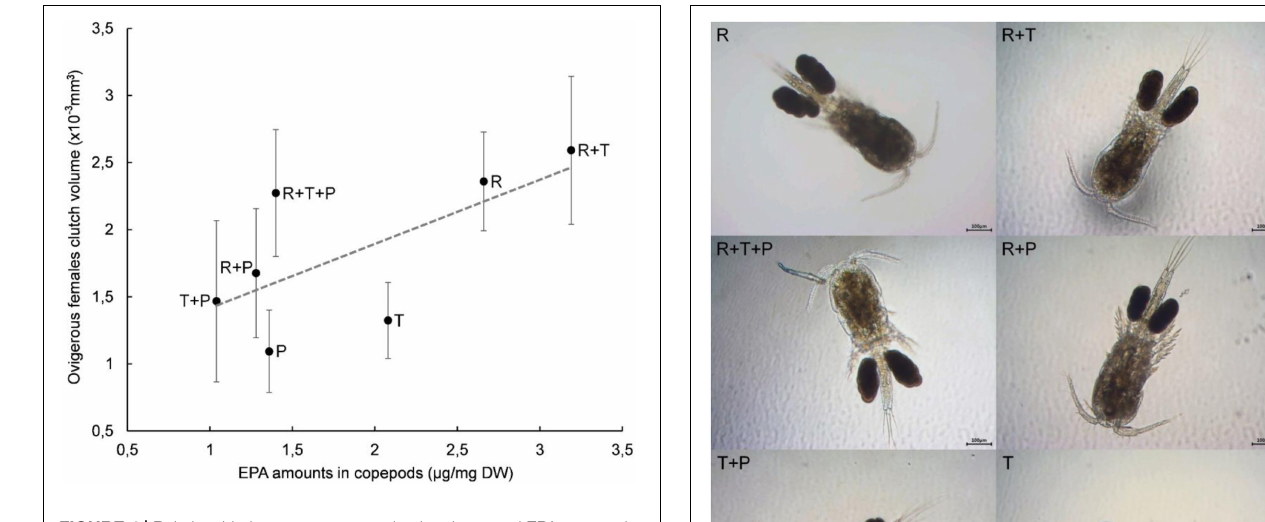
FIGURE 4 | Relationship between average clutch volume and EPA amount in Paracyclopina nana ovigerous females for each microalgal diet. Error bars show the standard deviations obtained from n = 20 females. Dashed line corresponds to the linear regression (EV = 0.4781 X PV + 0.9374, R 2 = 0.446, p < 0.01). Pearson’s test was performed to determine the significance of the coefficient of determination R 2 . R, Rhodomonas salina ; T, Tisochrysis lutea ; P, Pavlova lutheri.